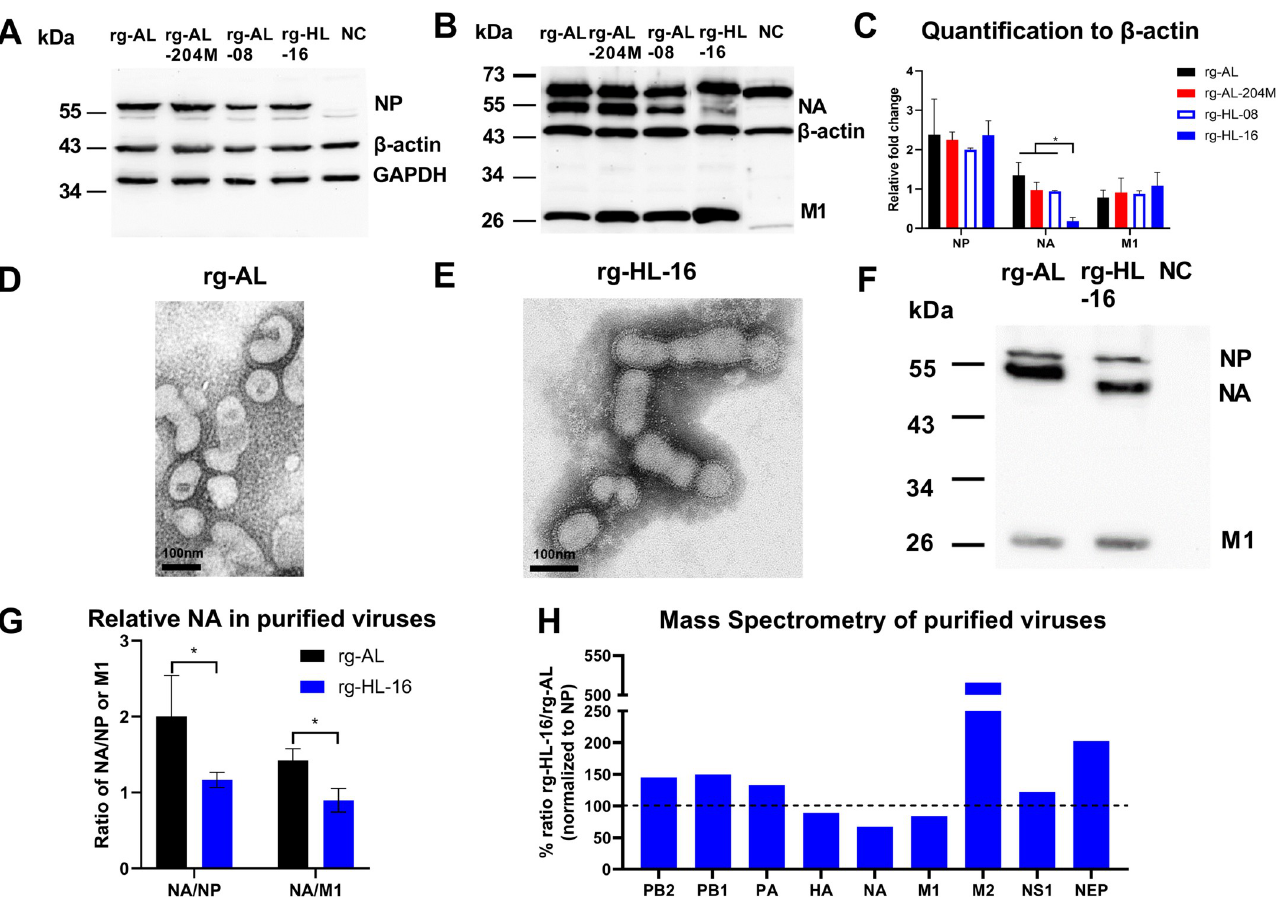
Fig 4. Relative NA expression in infected cells and purified virions. NA, M1 and NP expression in MDCK-II cells infected with an MOI of 1 with the indicated viruses for 24 h (A-C). Commercial monoclonal antibodies against M1, NP, β -actin or GAPDH (A) or polyclonal anti-N1-antibodies (B) were used as primary antibody. NC refers to non-infected cells as a negative control. The upper band in panel B is non-specific. The chemiluminescence signal of M1, NP or NA was normalized to β -actin (C). The test was done four times and the protein expression was calculated as mean and standard deviation of all replicates. Normalization of different proteins to β -actin or GAPDH yielded the same pattern (C). Shown is the ultrastructure of the purified rg-AL and rg-HL-16 viruses using negative staining (D, E) and the relative NA-content of purified virus particles using Western blot (F, G). Mass spectrometry-based quantification of viral proteins in purified virus particles. The amount of each protein of purified rg-AL and rg-HL-16 were normalized to the homologous NP protein. Relative results for rg-HL- 16:rg-AL are shown (H). The results are representative for at least 3 independent experiments. The dashed line shows 100% expression level of rg-HL-16 in comparison to rg-AL. Asterisks indicate significant differences compared with rg-AL at p < 0.05.